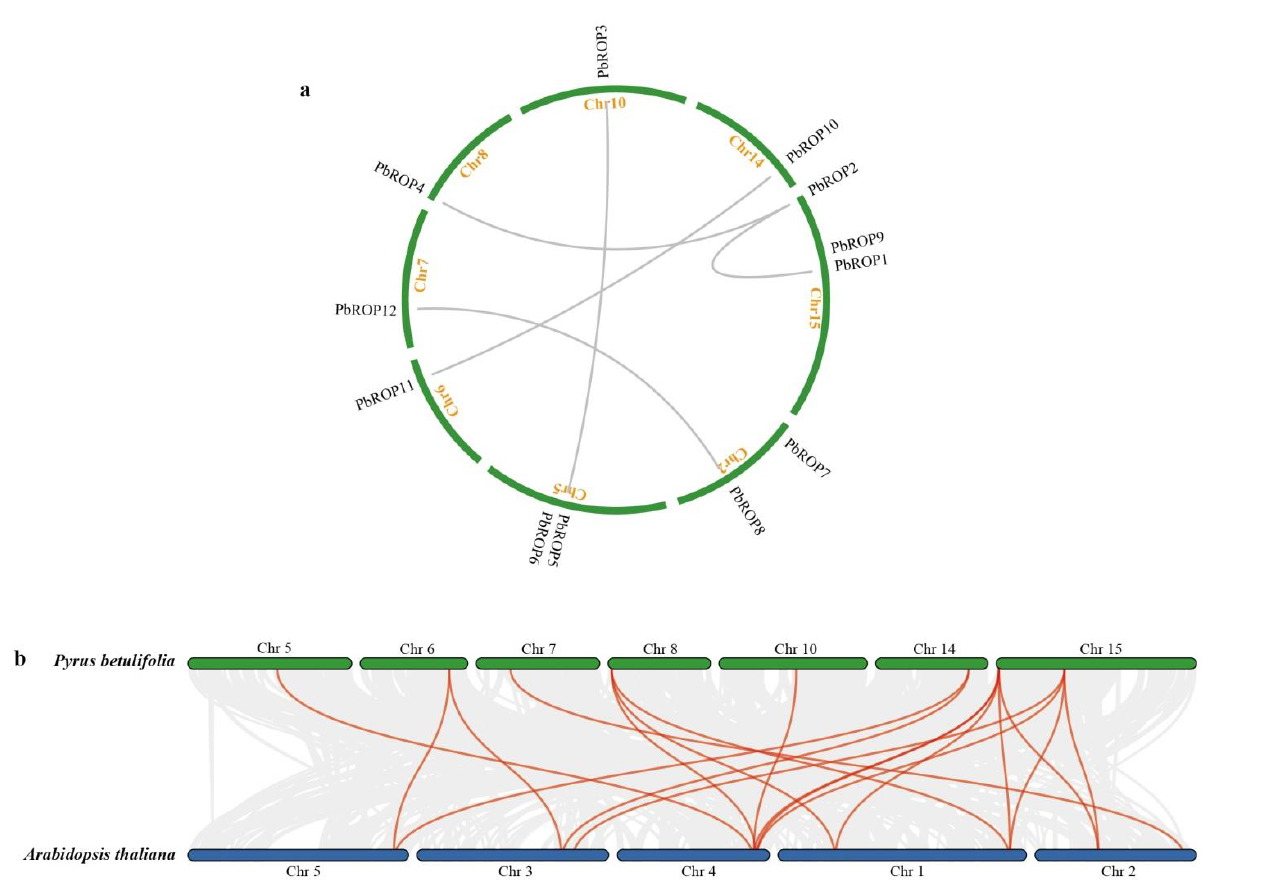
Figure 5. Inter-chromosomal relationship of PbROPs of ‘ Duli ’ pear ( Pyrus betulifolia Bunge) and synteny analysis of PbROPs and AtROPs of Arabidopsis. ( a ) Schematic representations of the chromosomal distribution and inter-chromosomal relationships of PbROPs of ‘ Duli ’ pear. Gray lines indicate duplicated ROP genes. The chromosomes are presented as green lines, which are labeled with orange letters. ( b ) Synteny analysis between PbROPs of ‘ Duli ’ pear and AtROPs of Arabidopsis. Gray lines in the background indicate the collinear blocks that are highlighted in red lines to indicate the syntenic ROP gene pairs between PbROPs and AtROPs